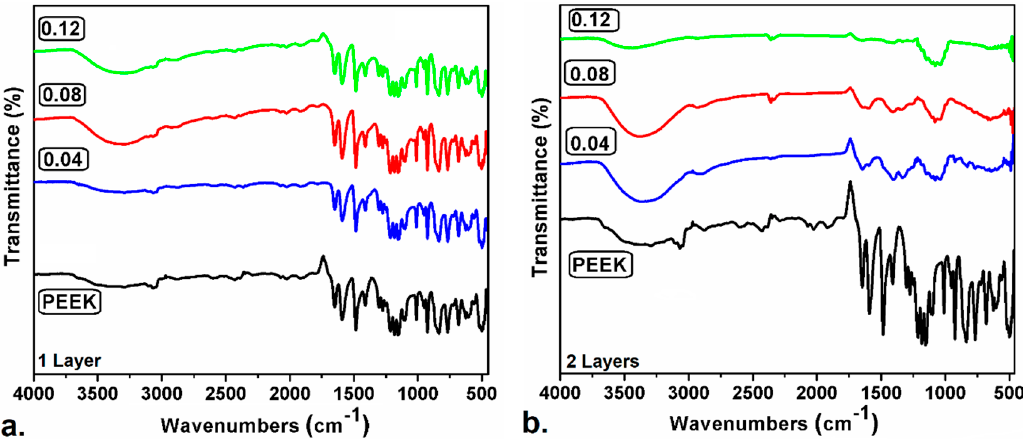
Figure 2. Fourier transform infrared (FTIR) of PEEK/Ag0.04, PEEK/Ag0.08 and PEEK/Ag0.12 samples ( a ) with one coating layer and ( b ) with two coating layers.